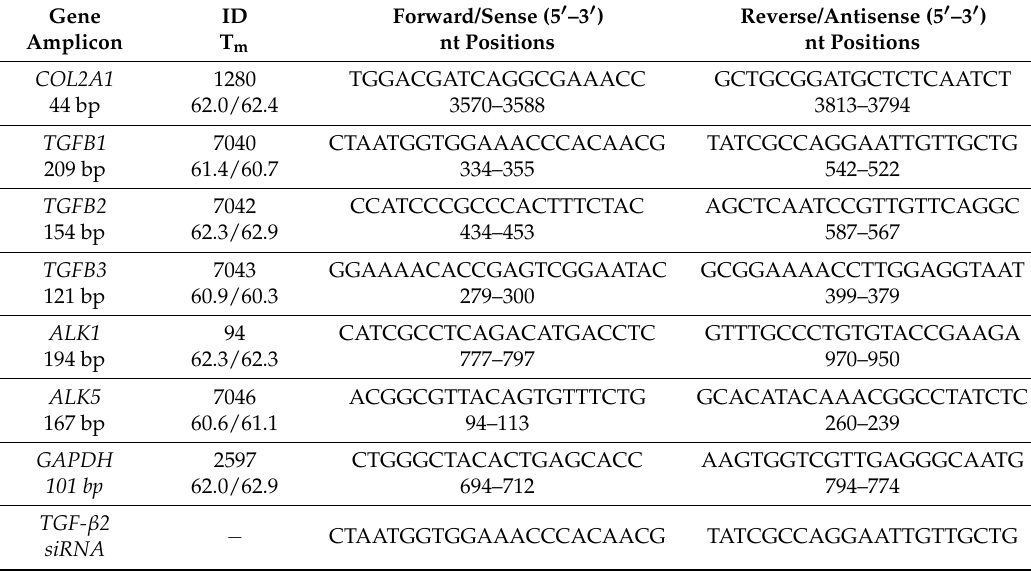
Table 1. Oligonucleotide